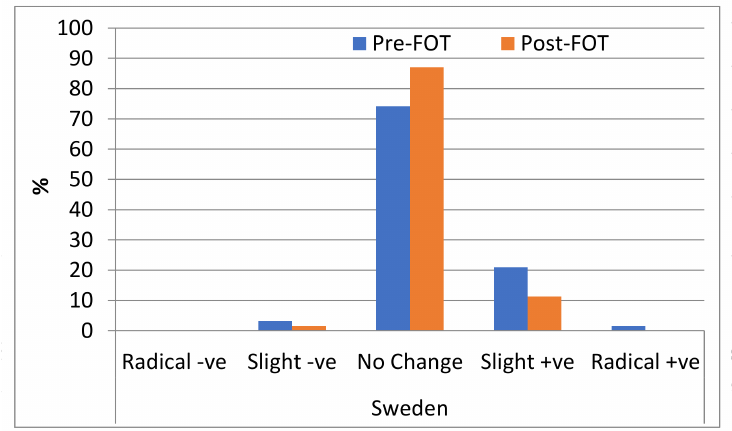
Figure 4. Green Driving Support: perception of safety pre- and